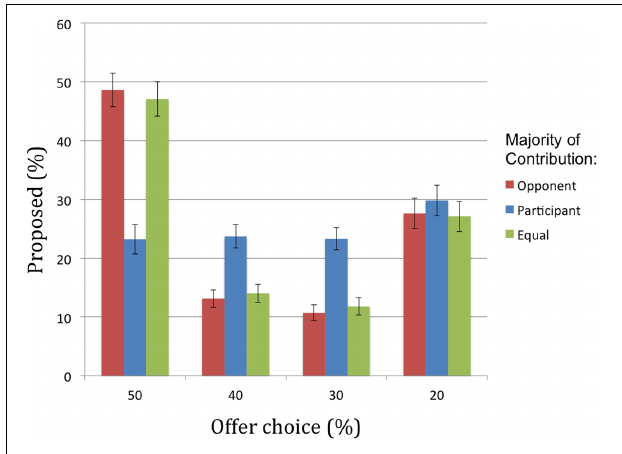
FIGURE 3 | Percentage of accepted offers by opponent offer ranging from very unequal (10%) to equal (50%) for each contribution condition.